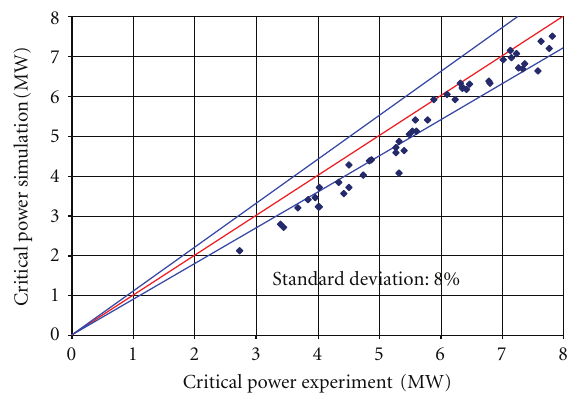
Figure 19: Measured and simulated critical power values for assem- bly